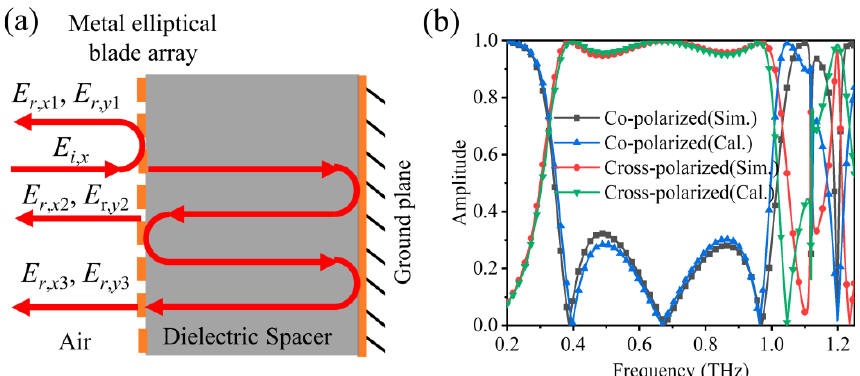
Figure 8. ( a ) Schematic of multiple reflection in the Fabry–Pérot-like cavity. ( b ) Simulation and calculation results of reflection spectra of the designed metasurface.